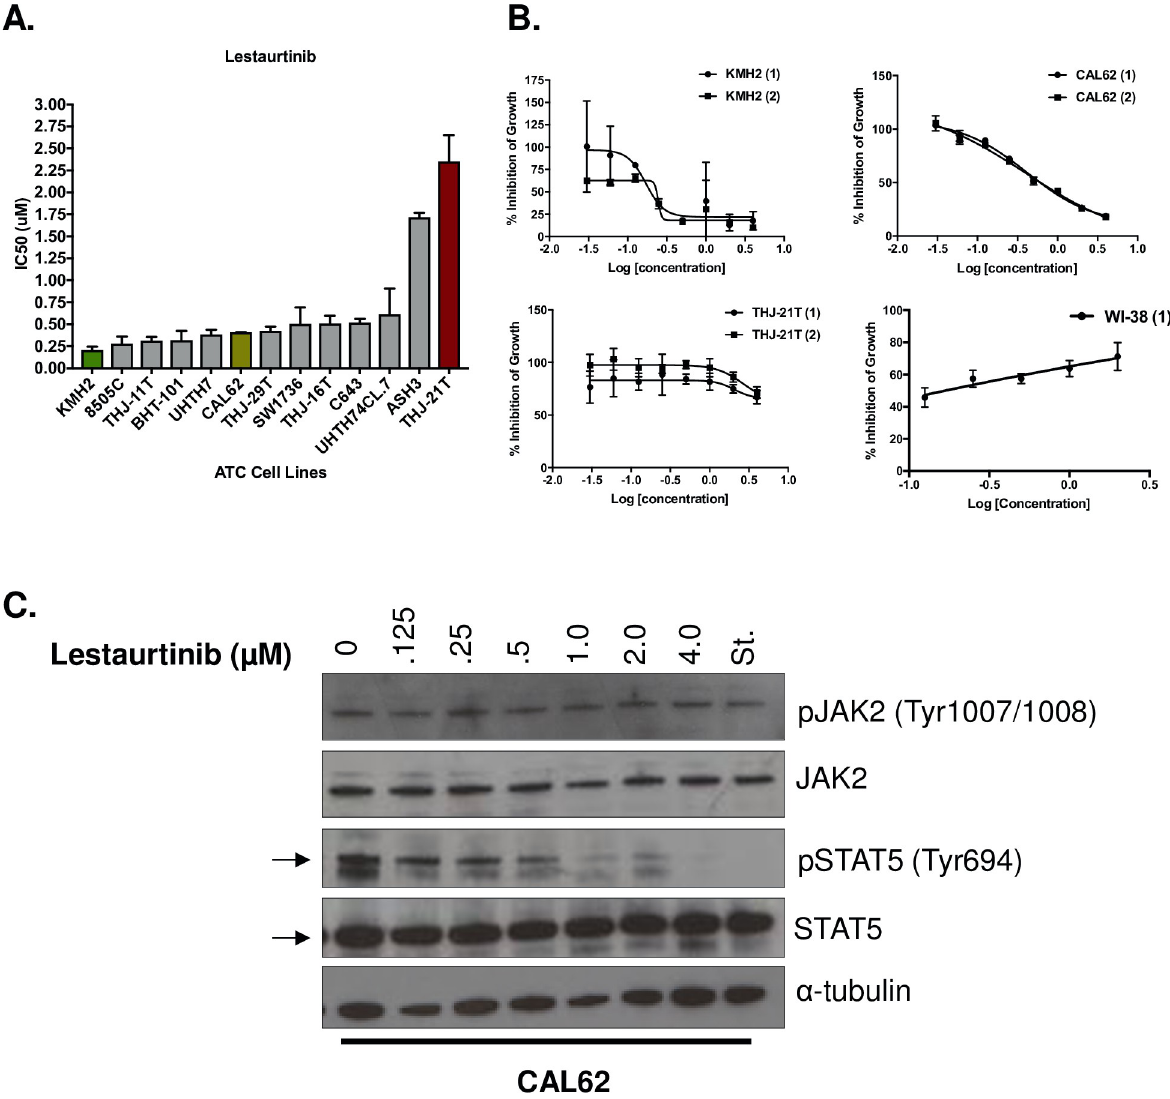
Fig 1. Lestaurtinib is identified as a potent agent across a panel of 13 ATC cell lines. (A) Lestaurtinib was tested against 13 ATC cell lines, with 2 biological replicates per cell line. Cells were treated with Lestaurtinib for 48 h and readings were completed after incubation with AlamarBlue. Mean IC 50 values are shown ± standard deviation, stratified by lowest to highest mean values. (B) Dose-response curves demonstrating the effect of Lestaurtinib ( μ M) on cell growth following 72 h of treatment for KMH2, CAL62, THJ-21T (2 biological replicates) and WI-38 (1 biological replicate) cell lines. (C) Western blot of p-JAK2, JAK2, p-STAT5 and STAT5 showing protein expression of cells that were either untreated or treated with increasing concentrations (.125–4 μ M) of Lestaurtinib, relative to the Staurosporine (St.)